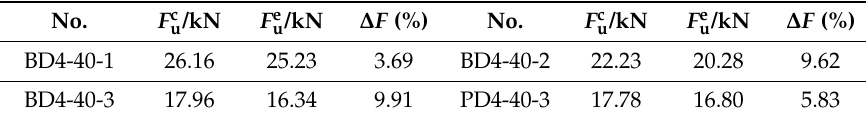
Table 6. Calculated and experimental results of ultimate